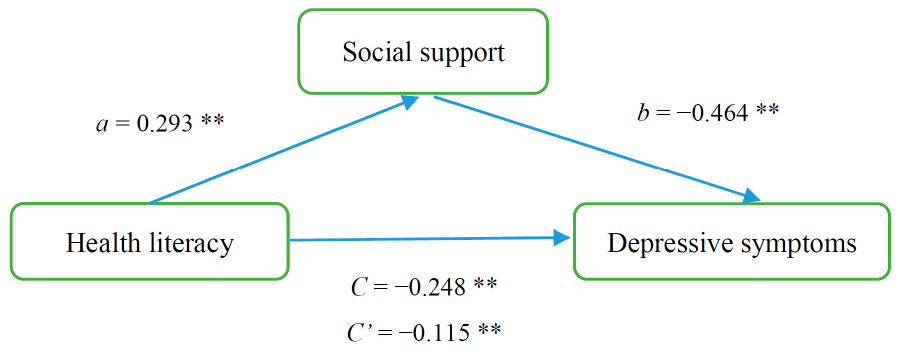
Figure 1. The mediating effect of social support on the relationship between health literacy and depressive symptom. ** p < 0.01.